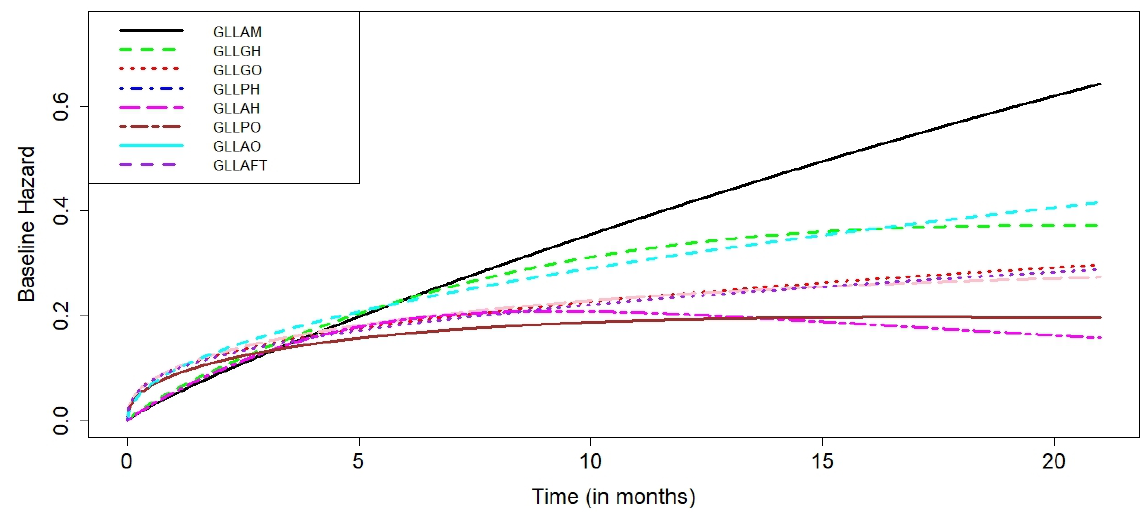
Figure 5. Estimated hrfs for the competitive models of the IPASS